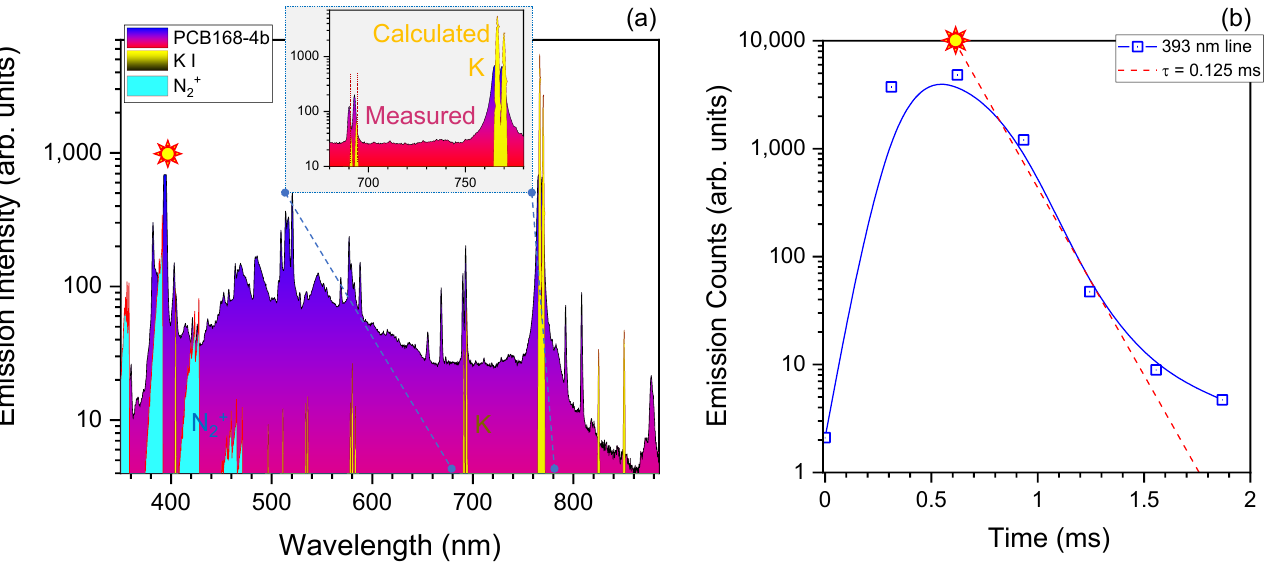
Figure 3. ( a ) Emission of thermitePCB 168-4b (same as Figure 1b) overlayed with K I emission from LIBS (NIST database [17]). The inset shows match between the predicted spectral positions of the K I (I for the neutral element) lines and experimentally measured thermite emission. For illustration of molecular spectral shape, the emission of the molecular N + shown (Specair 3.0). ( b ) Temporal evolution of the 393 nm band (matching peak emission of Al I from the µ-thermite and N + from the loaded chemical BKNO 3 ). The one-exponential fit with τ = 0.125 ms (dashed 2